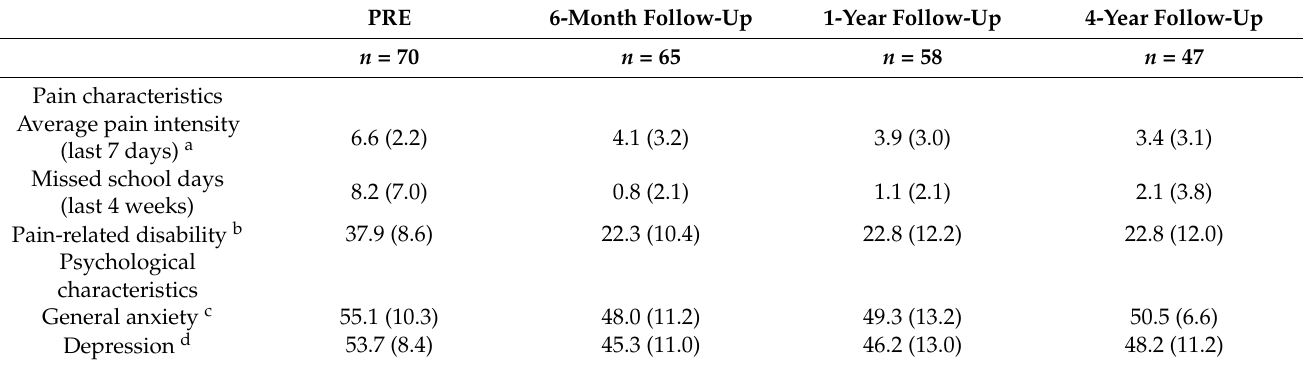
Table 2. Pain-related and psychological outcomes (means and standard